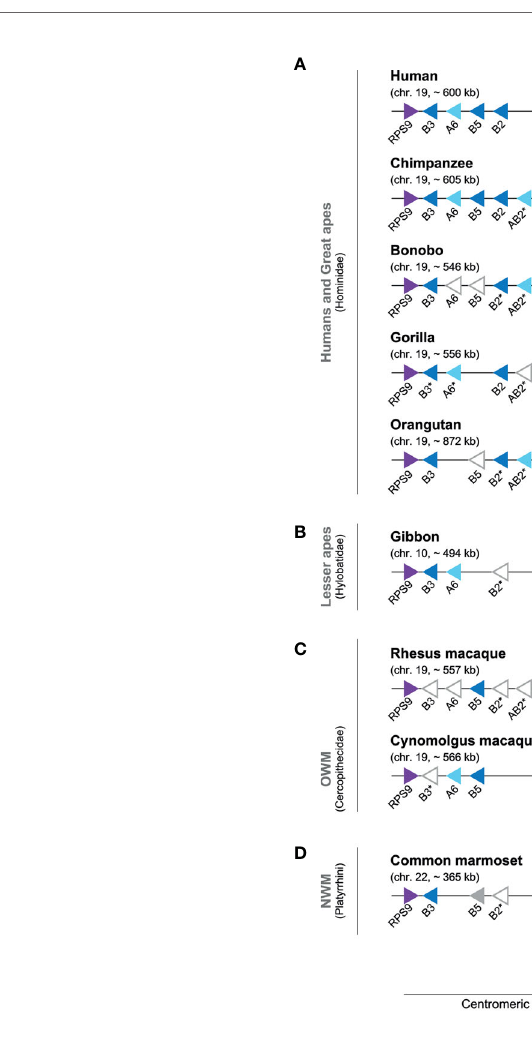
FIGURE 5 | Genomic organization of the LILR region in different primate species. Genomic organization of the LILR region in human and great apes (A) , lesser ape (B) , and representatives of the OWM (C) and NWM (D) species ( Table S2 ). Each different LILR gene present on a genome is indicated by a colored arrow aligned in such a way that it points in the direction of transcription: RPS9 (purple), LILRA (light blue), LILRB (dark blue), LAIR (green), KIR (red), FCAR (yellow), and pseudogenes or genes indicated by NCBI as non-functional, such as bonobo LILRA8 (grey). The arrows with only a gray outside line represent genes that are indicated by NCBI with low quality protein ( Table S3 ), and the expression status of these genes is currently uncertain. The sequence of cynomolgus macaque LILRA1 , found after reannotation of LILRA2 ( Table S3 ), shows only a correct alignment up to the exon encoding for the third domain structure, and most likely represents a pseudogene. The absence of LILRB2 and LILRAB2 on the reference genome of cynomolgus macaques might be an assembly error, as a stretch of approximately 35 kb is identi fi ed in this region, which contains an unrelated gene ( Table S3 ). The central region is indicated by an interception with two vertical lines. The dotted line (common marmoset) illustrates a large genomic region between LILRB4 and the FCAR lacking annotation. The genes indicated with an asterisk have been renamed using standardized LILR gene nomenclature (previously used names are listed in Table S3 ), and particular of these genes were found by re-annotation ( Table S3